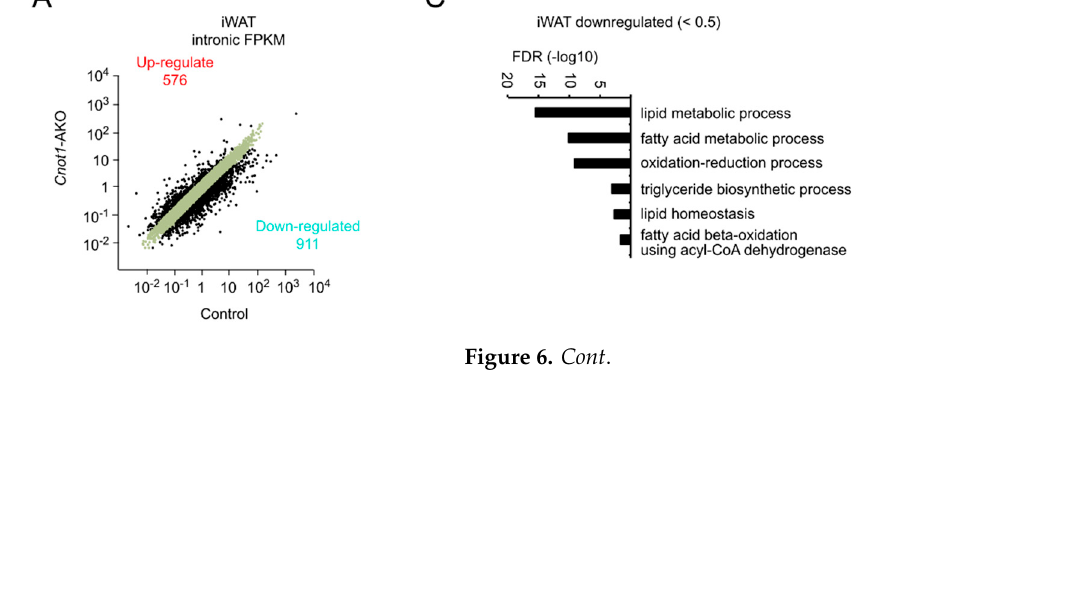
Figure 6. Changes in pre-mRNA abundances are responsible for gene expression differences between control and Cnot1 -AKO mice. ( A,B ) Scatter plots of intronic fragments per kilobase of exon per million mapped sequence reads (FPKMs) in iWAT ( A ) and BAT ( B ) of 12-week-old control and Cnot1 -AKO mice ( n = 4). Black dots represent pre-mRNAs whose expression differed more than two-fold in Cnot1 - AKO mice compared to controls. ( C,D ) GO enrichment analysis of genes showing intronic FPKMs that increased or decreased more than two-fold in iWAT ( C ) and BAT ( D ) of 12-week-old Cnot1 -AKO mice. Bar charts of the BP GO terms (at most six) ranked by FDR (<0.05) are shown. Note that no significant enrichment of the BP GO terms occurred for increased pre-mRNAs in iWAT. Gene lists included in each GO term are summarized in Supplementary Tables S5 and S6. 3. Discussion The CCR4–NOT complex serves essential functions in the development and homeostasis of various mammalian tissues [20,25–30]. In murine adipose tissues, the complex prevents disease- related phenotypes, such as obesity and lipodystrophy [25,28]. Suppression of the CCR4–NOT complex leads to stabilization of mRNAs in various tissues, and these stabilized mRNAs are responsible for functional abnormalities. In this study, we found that in adipocytes, mRNAs were stabilized upon CCR4–NOT complex suppression, but mRNA stabilization was not the primary factor causing dysregulated gene expression. Compared to the number of upregulated mRNAs in BAT of Cnot1- AKO mice, a much smaller number of mRNAs showed stabilization, and many more mRNAs were destabilized (Figures. 4B and 5B). Increased pre-mRNA levels accounted for most of the increased expression of mRNAs (Figure 6B,D). Similarly, mRNA destabilization and changes in pre-mRNA expression were more responsible for dysregulated gene expression than mRNA stabilization in iWAT of Cnot1 -AKO mice (Figures 4–6). Pre-mRNA expression is used as a proxy for transcription rate [34], suggesting that changes in transcriptional programs contribute to differences in gene expression in adipose tissues between control and Cnot1 -AKO mice. Previous studies have shown that the CCR4–NOT complex directly regulates transcription in mammals [35–39], suggesting a critical interaction between the CCR4–NOT complex and the transcription machinery directly or indirectly in murine adipocytes. Importantly, in yeast, other mRNA decay factors in addition to the